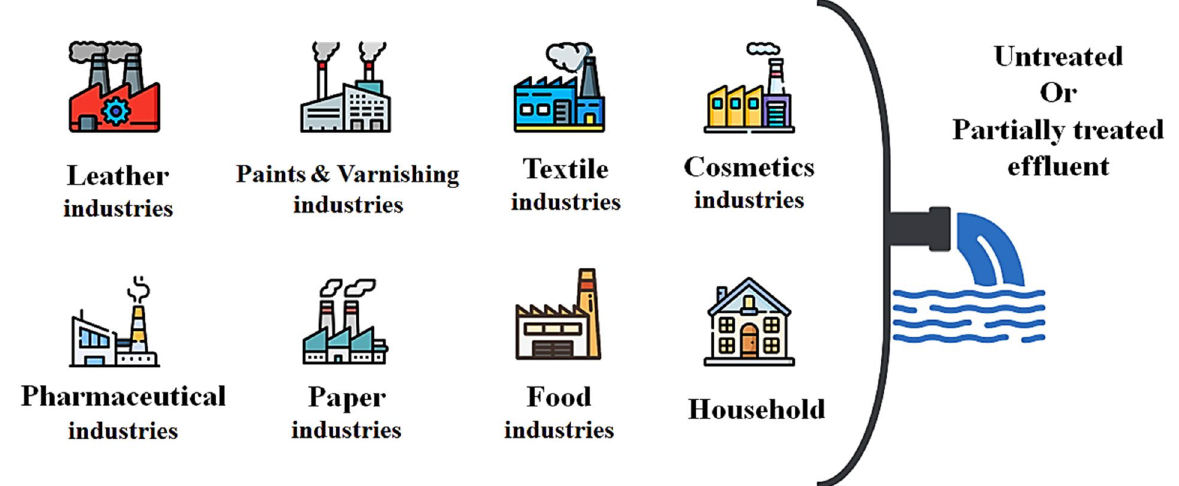
Figure 1. Different sources of discharging dyes into the aquatic